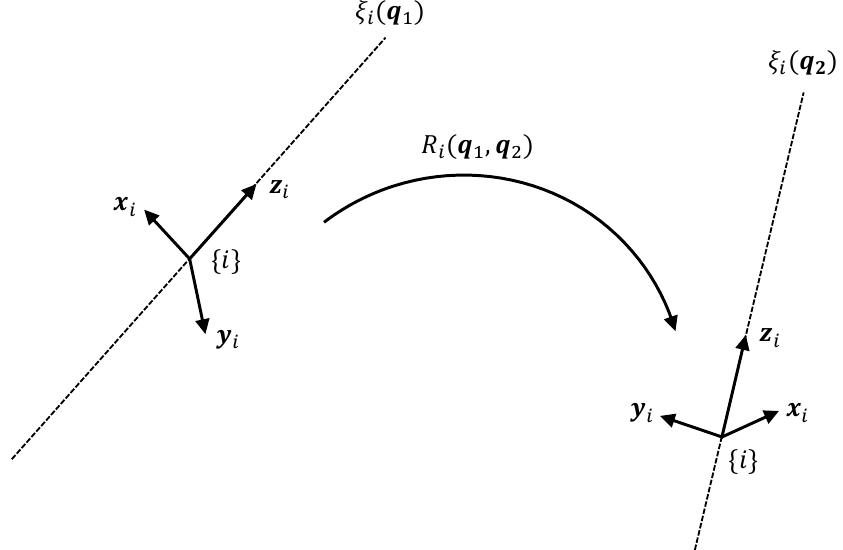
Figure 3. Rotor R i relating the twist ξ i in two different configurations q 1 and q 2